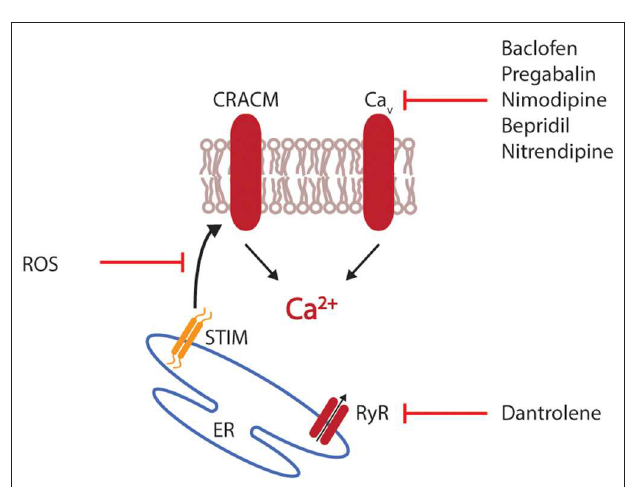
FIGURE 2 | Interference with calcium mobilization. Therapeutic intervention with calcium mobilization can target the initial release of calcium from the endoplasmic reticulum (ER), for example by interfering with the ryanodine receptor (RyR). Alternatively, the interaction of stromal interaction molecule 1 (STIM1) with CRAC modulator 1 (CRACM1) can be disturbed by reactive oxygen species (ROS). Most available drugs target voltage-gated calcium channels (Ca v